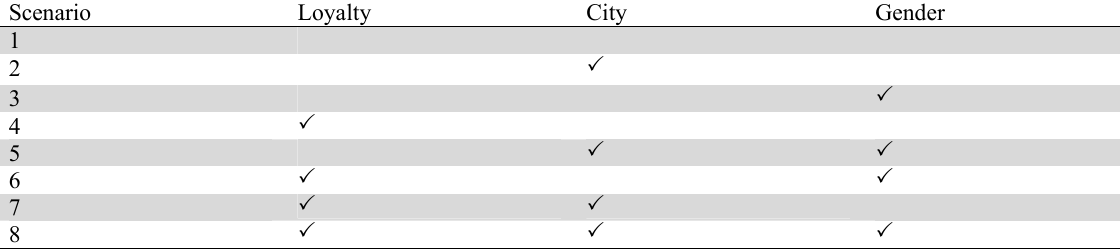
Different scenarios based on customer loyalty level and market segmentation variables Scenario